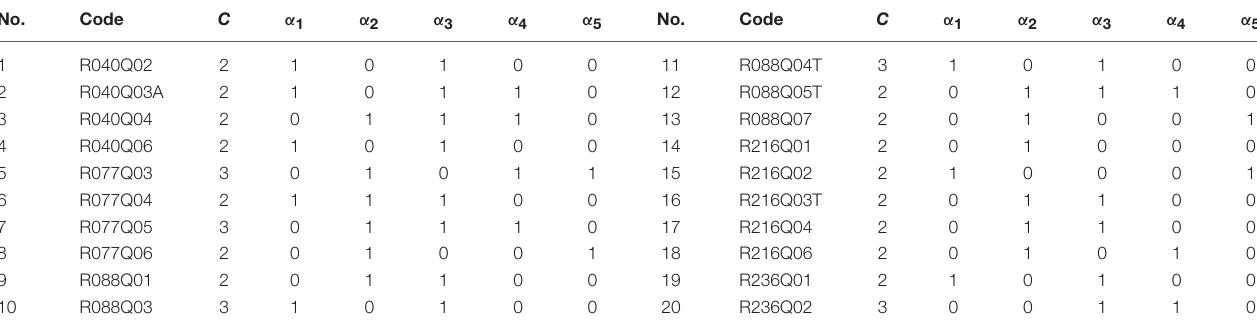
TABLE 4 | Items and Q-matrix for the PISA